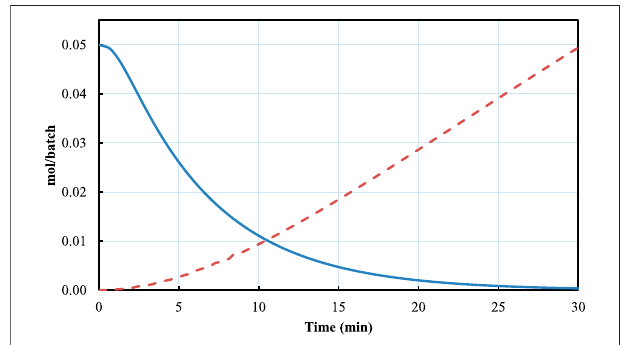
FIGURE 5 | Theoretical prediction of FAME production --- and TG consumption, experiment # 9.